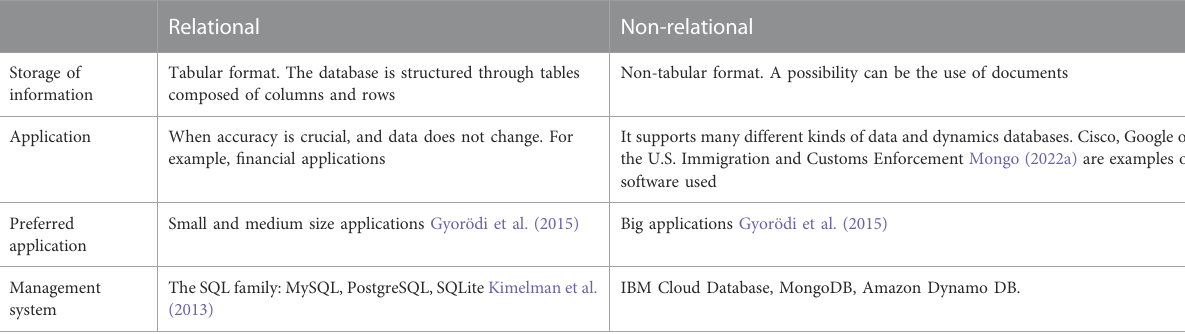
TABLE 1 Main differences between relational and non-relational databases.